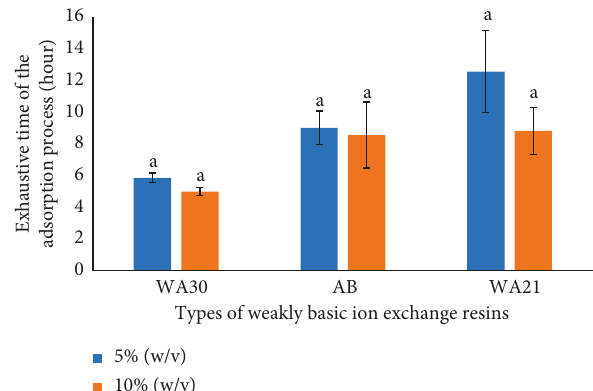
Figure 6: Effect of adsorbent dose at 5% (w/v) and 10% (w/v) on the saponin adsorption exhaustive time (hour). a: the same al- phabet indicate no significant difference ( p